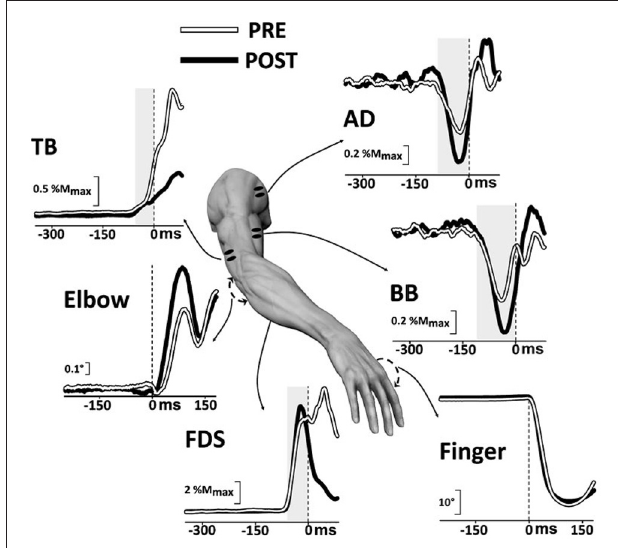
FIGURE 5 | Intra-limb APAs change after short-term immobilization. Average recordings in a representative subject before (PRE, white) and after (POST, black) immobilization. When rapidly flexing the index-finger (prime mover FDS), the arm equilibrium is preserved thanks to APAs (shaded area), which are excitatory in TB and inhibitory in BB and AD. After a 12-h immobilization of the wrist and fingers, FDS activation preceding the movement onset and index-finger movement were unchanged. Instead, inhibitory APAs in BB and AD apparently increased, while excitatory APA in TB was marginally decreased. The changes in the postural chain led to a less effective fixation of the elbow joint, which showed a larger displacement during index-finger acceleration. EMG amplitude was normalized to the maximal motor response ( M max ) evoked by orthodromic nerve stimulation. Reproduced from Bolzoni et al. (2012), © Springer-Verlag 2012, with permission of Springer